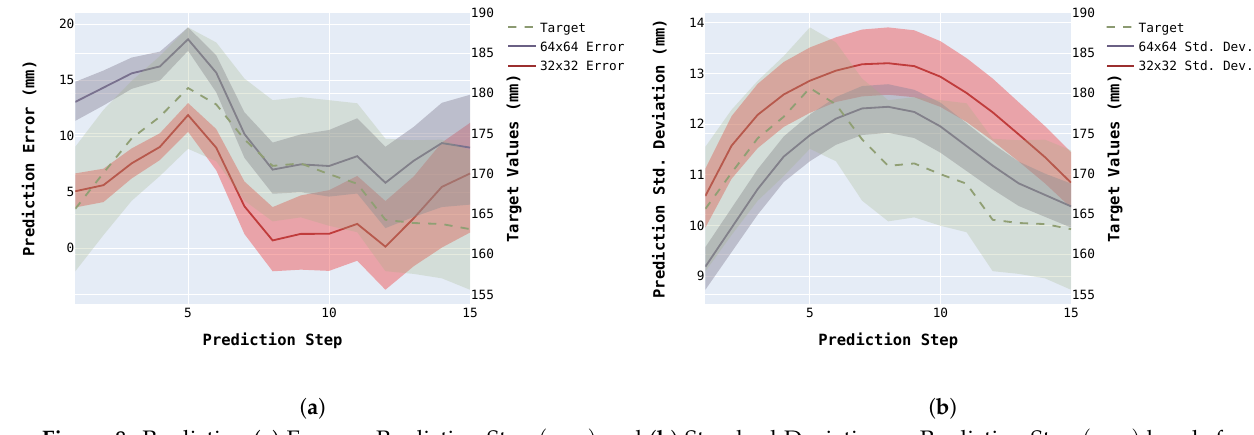
Figure 8. Prediction ( a ) Error vs Prediction Step ( mm ) and ( b ) Standard Deviation vs Prediction Step ( mm ) bands for 50%,75%,25% quantile range for δ = { 32,64 } , s = 4 for a 10 m × 10 m pasture for L out = { 1,6,11,15 } , respectively, and ground truth prediction from the 3D Pasture generated in Gazebo depicting the rate of change of pastures over 60 days. We observe that the lower quantization δ = 32 outperforms the larger input quantization over the complete predicted time period.